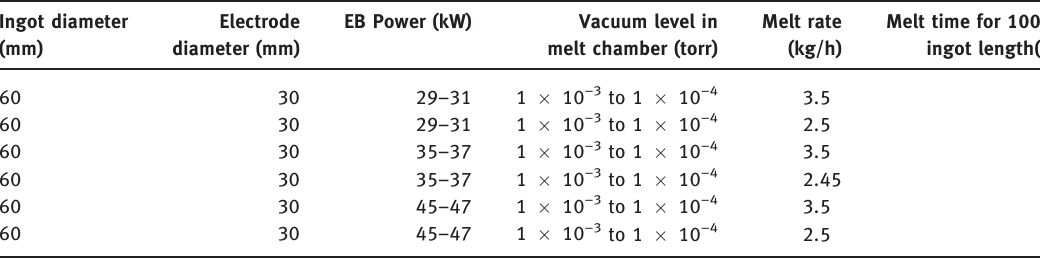
Table 2: EBM process parameters for 60 mm diameter ingot. Ingot diameter